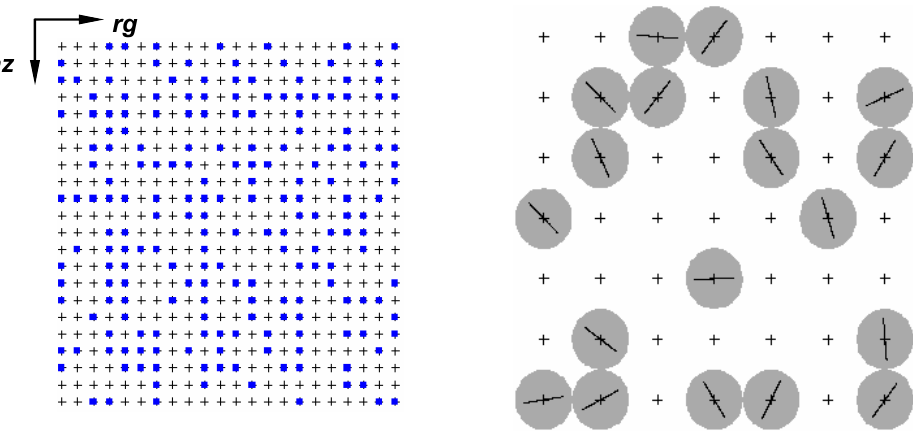
Figure 6. Rectangular grid with a few selected dipole positions and a zoomed